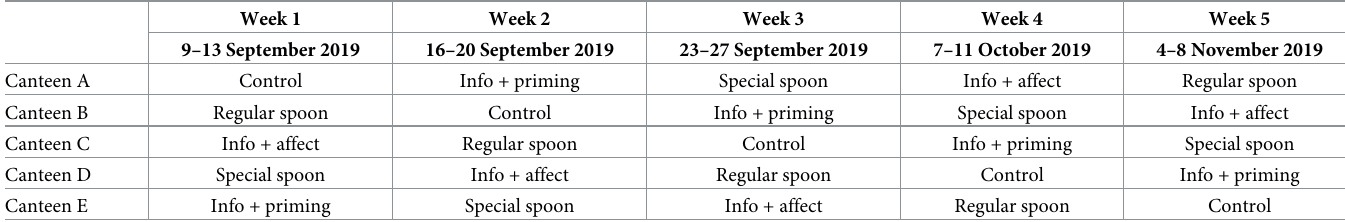
Table 1. Latin square design of interventions across weeks and